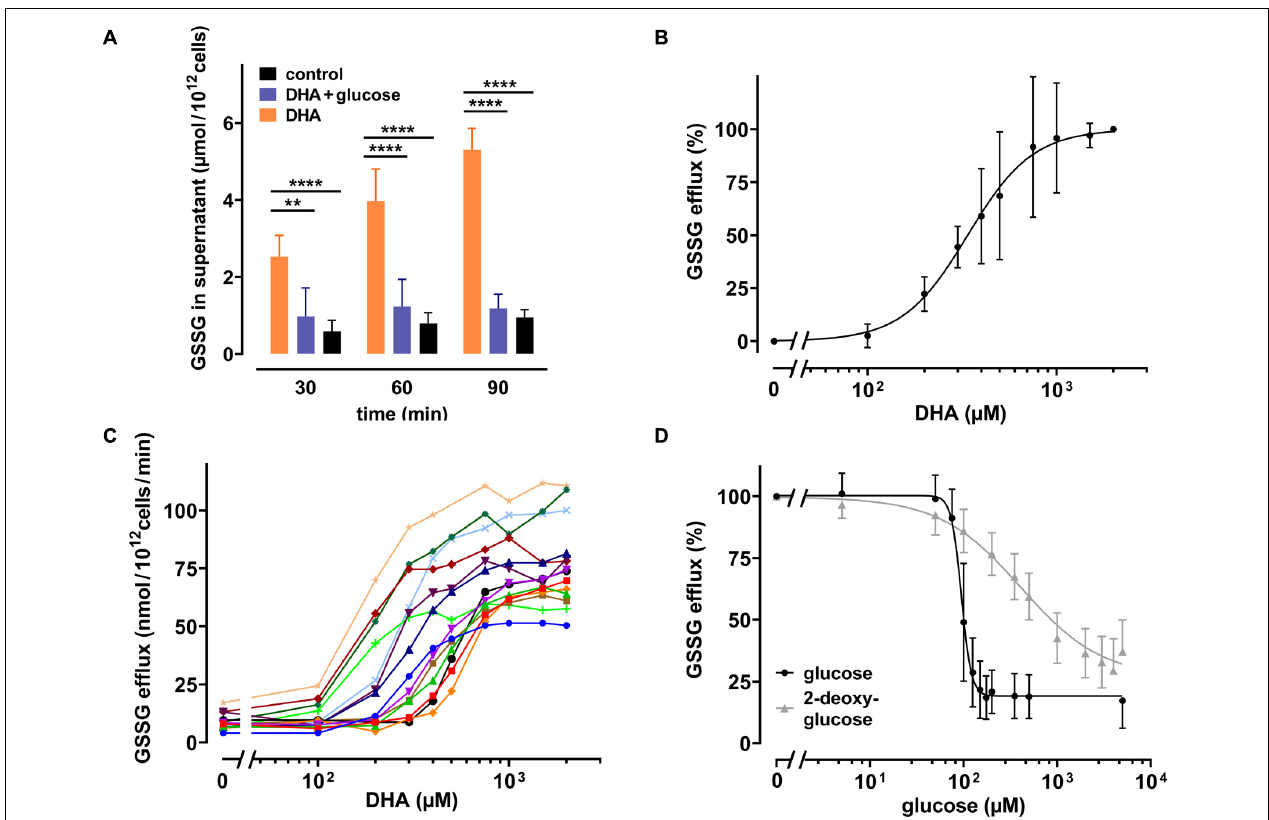
FIGURE 4 | DHA-dependent GSSG efflux from erythrocytes is rescued by glucose as well as 2-DG. (A) Erythrocytes ( n = 7) were incubated with 2 mM DHA in the absence (orange) or presence (blue) of 5 mM glucose for 15 min at RT. Control incubations were carried out in PBS (black). Afterward, cells were washed and resuspended in PBS (black and orange) or PBS containing 5 mM glucose (blue). Aliquots were taken at indicated time points and GSSG concentrations in the supernatant enzymatically assessed as described in the section “Materials and Methods”. (B,C) Erythrocytes ( n = 14) were treated with various amounts of DHA for 15 min at RT, washed and resuspended in PBS for 90 min. GSSG content in the supernatants was assessed and the efflux rates calculated. Data are given as mean values in percent after normalizing to control conditions (pre-treatment with 2 mM DHA in PBS - 100%; PBS control cells - 0%, respectively) (B) , or in absolute values for individual experiments (C) . (D) Erythrocytes ( n = 14) were treated with 2 mM DHA in the presence of glucose (black) or 2-DG (gray) for 90 min at RT and the GSSG content in the supernatant assessed. GSSG efflux rates are given in percent after normalization to control conditions (pre-treatment with 2 mM DHA in PBS without glucose or 2-DG - 100%; PBS control cells - 0%,